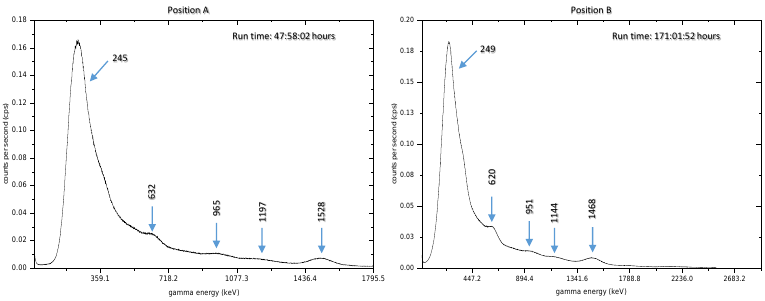
Figure 4. (Left) The background γ -ray spectrum at the position A in the accelerator hall. NaI(Tl) detector has been placed at 132 cm from the FRENA concrete wall. (Right) The background γ -ray spectrum at the position B in the beam hall. NaI(Tl) detector has been placed at 265 cm from the FRENA concrete wall, where the other detectors supposed to be placed during the beam operating